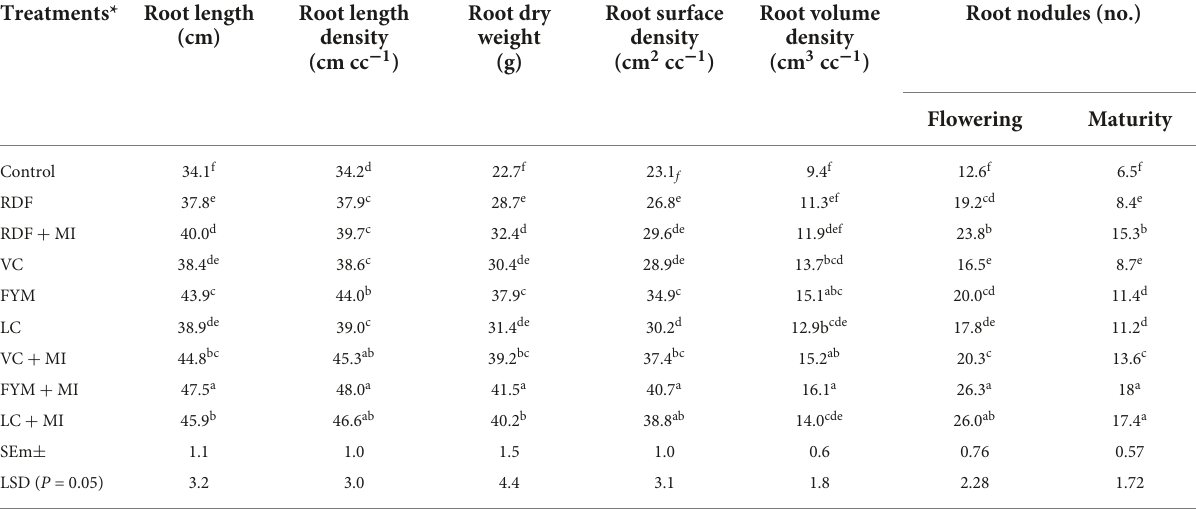
TABLE 5 Influence of microbial inoculants-mediated nutrient management on rhizospheric attributes (mean of 2-year data) of pigeonpea. Treatments* Root length